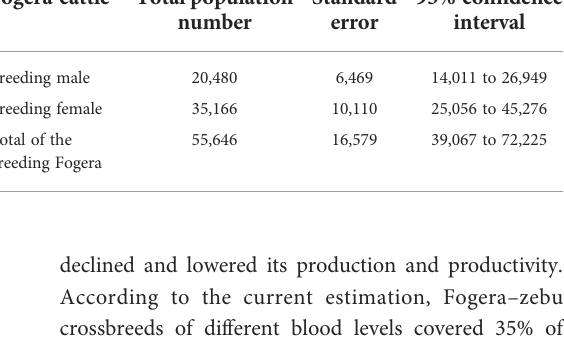
TABLE 11 Current population size of the Fogera cattle. Fogera